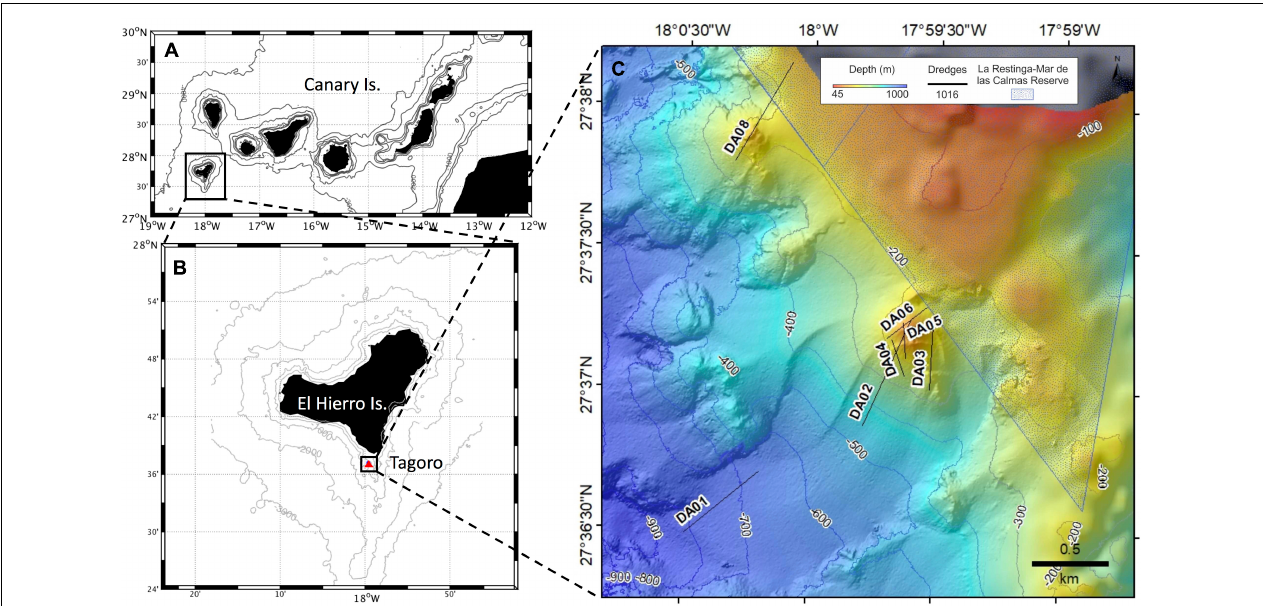
FIGURE 1 | Location map. (A) Location of the island of El Hierro in the Canary Archipelago. (B) Location of Tagoro submarine volcano south of El Hierro island. (C) Rock dredge sampling over the lava flow of Tagoro submarine volcano and control area northwest of the submarine volcano. Shaded triangle represents the domain of La Restinga - Mar de Las Calmas Marine